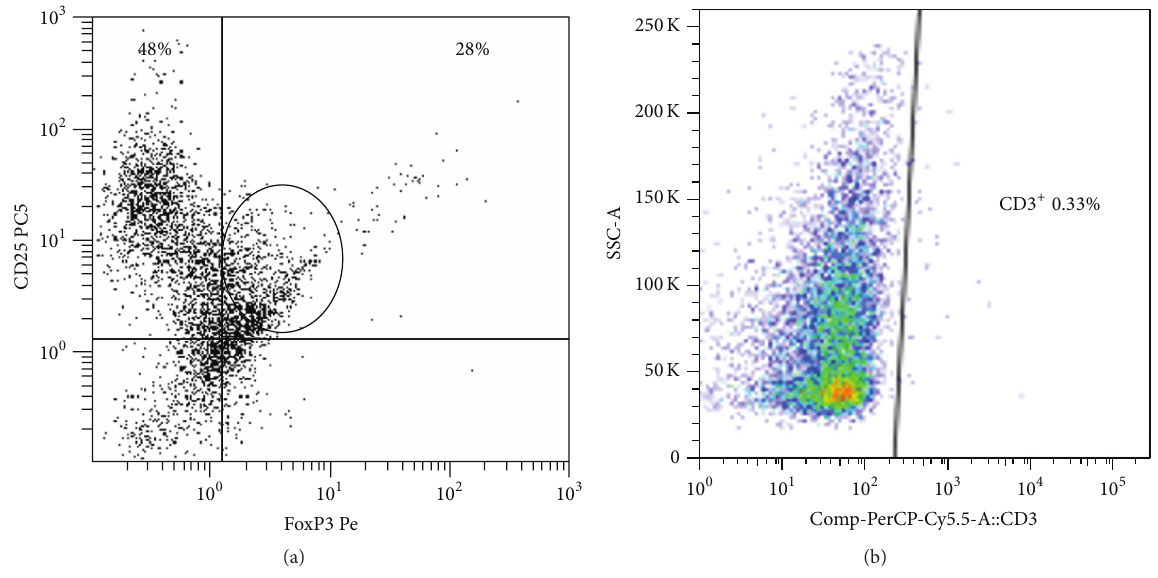
Figure 1: (a) A representative FACS analysis of purified B cells (expressing CD 25 high FoxP3) following CpG-ODN and CD40L activation. Of note is that CD 25 dim-low B cells (upper left quadrant) do not express FoxP3. However, CD 25 high B cells coexpress significant amount of FoxP3 (upper right quadrant). (b) A representative FACS analysis of purified activated B cells, showing that CD3 + T cell contamination (gated CD 3 + T cells) is less than 0.5%.